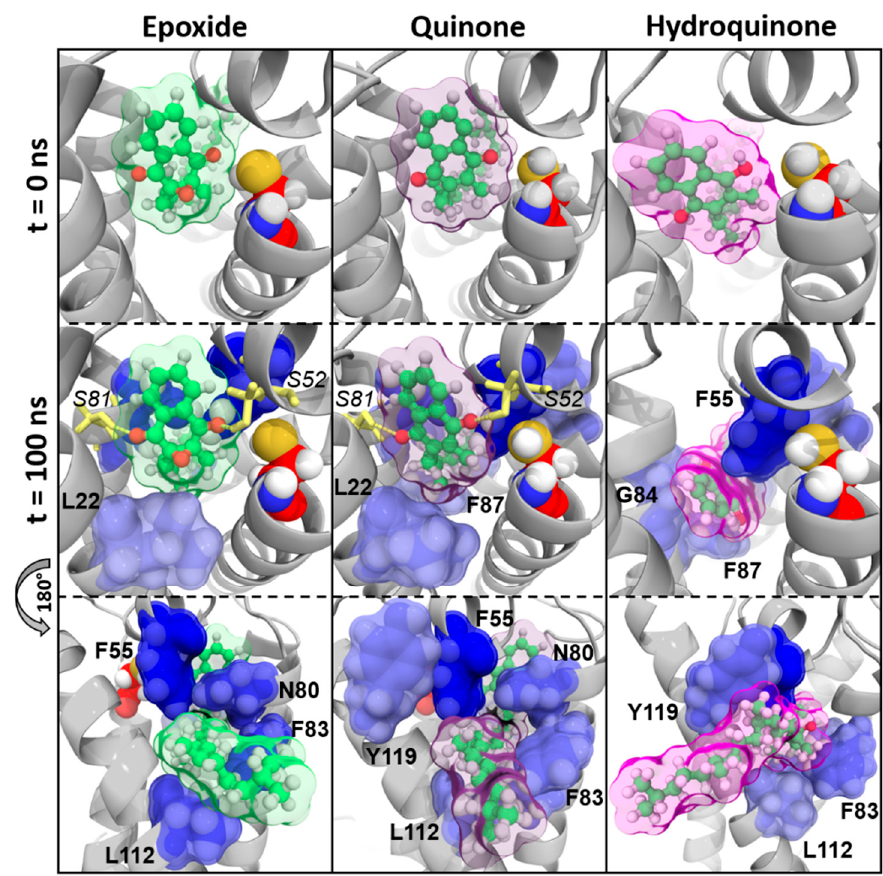
Figure 3. Vitamin K1 interactions with vitamin K epoxide reductase (VKORC1) in molecular dynamics (MD) simulations. Vitamin K1 is shown as green sticks and spheres; the transparent surface is colored as green, violet, and pink for epoxide, quinone, and hydroquinone states of vitamin K1, respectively. The VKORC1 protein structure is depicted as a grey image; the C135 residue is presented as red spheres. Oxygen, nitrogen, sulfur, and hydrogen atoms are colored in red, blue, yellow, and white, respectively. VKORC1 residues involved in hydrogen bonds with vitamin K1 are shown as yellow sticks (hydrogen bonds are depicted as yellow dashes) and numbered in italic characters. VKORC1 residues contributing to vitamin K1–VKORC1 binding free energy are presented as blue spheres and transparent surface (the darker the blue is, the stronger the interaction is) and numbered in bold